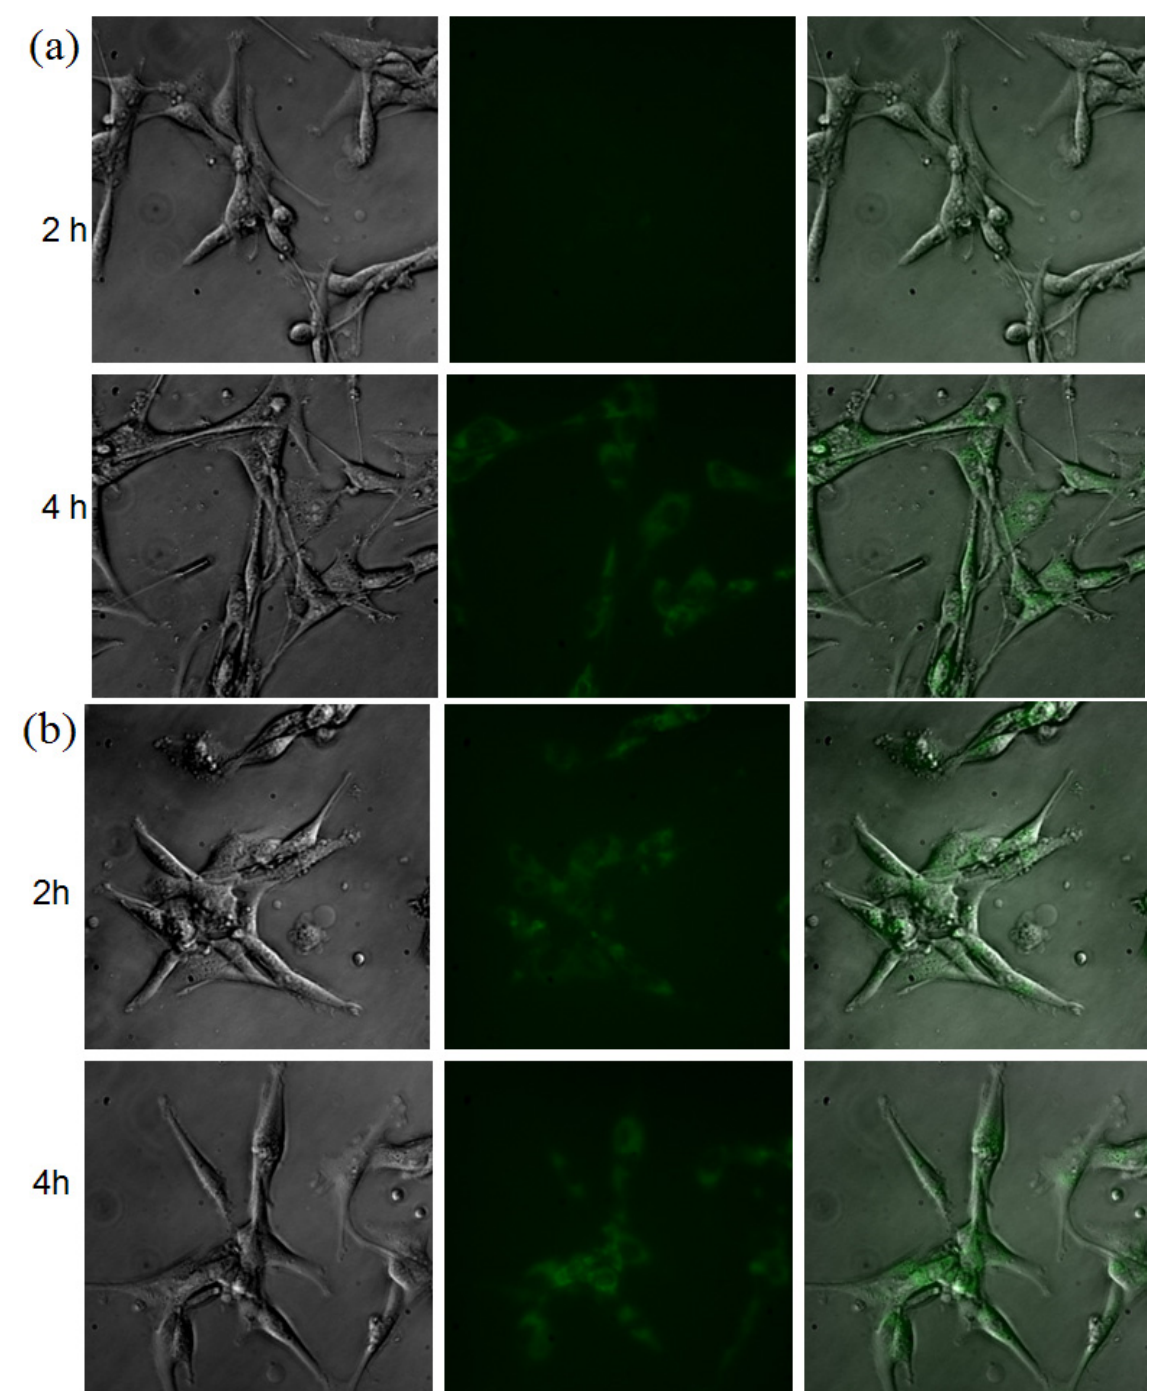
Figure 3. Representative microphotographs of A431 cells after incubation with ( a ) NIRF-CCPM and ( b ) DG-CCPM under (left) bright light, (middle) fluorescence microscope at 750 nm, and (right) overlap of bright light and fluorescence images. Original magnification × 20